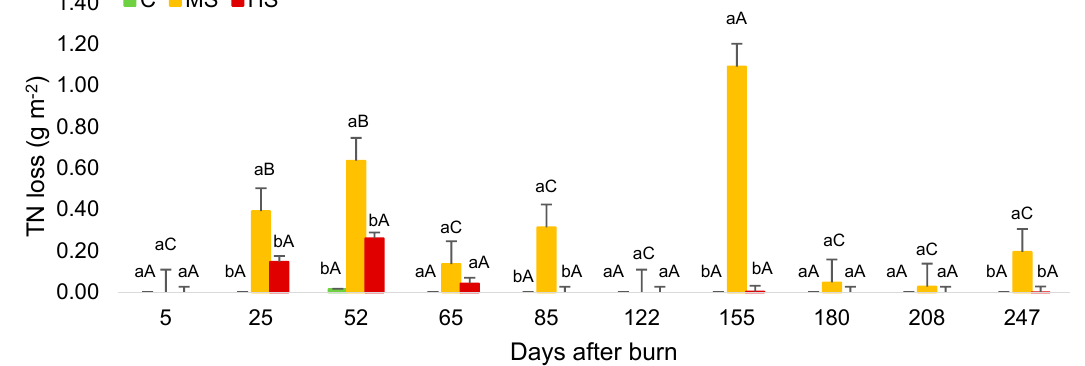
Figure 9. Treatment effect under control (C), moderate severity (MS), and high severity (HS) burn on total Nitrogen (TN) loss between 5 and 247 days after pile burning. Mean values followed by the different lowercase letters show statistically significant differences within the same date. Mean values followed by the different uppercase letters show statistically significant differences within the same treatment. Significant differences were observed at p < 0.05 . Hanging bars represent the standard error. ( n = 5).